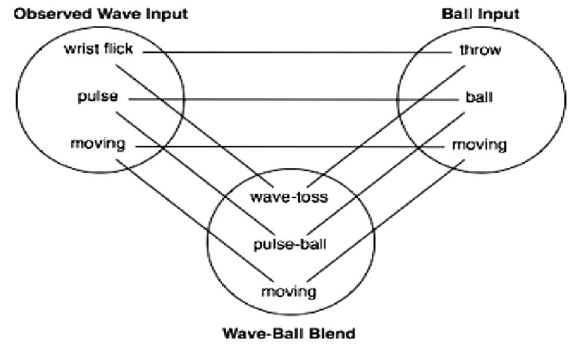
FIG. 1. Wave-ball blend from Wittmann [17].